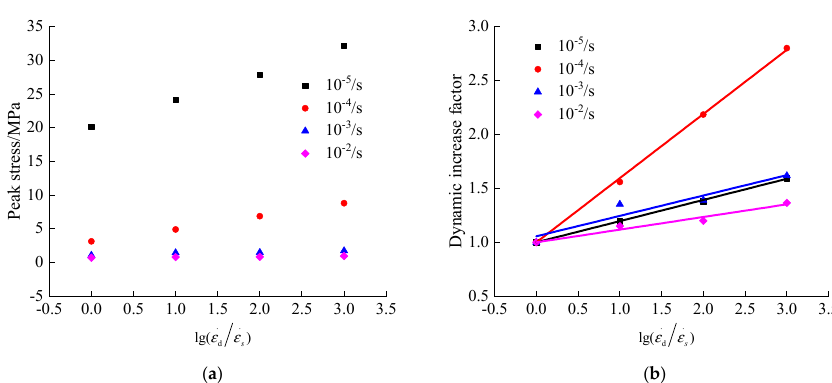
Figure 8. Relation between strain rate and peak compressive stress of hydraulic asphalt concrete. ( a ) peak stress; ( b ) dynamic increase factor.